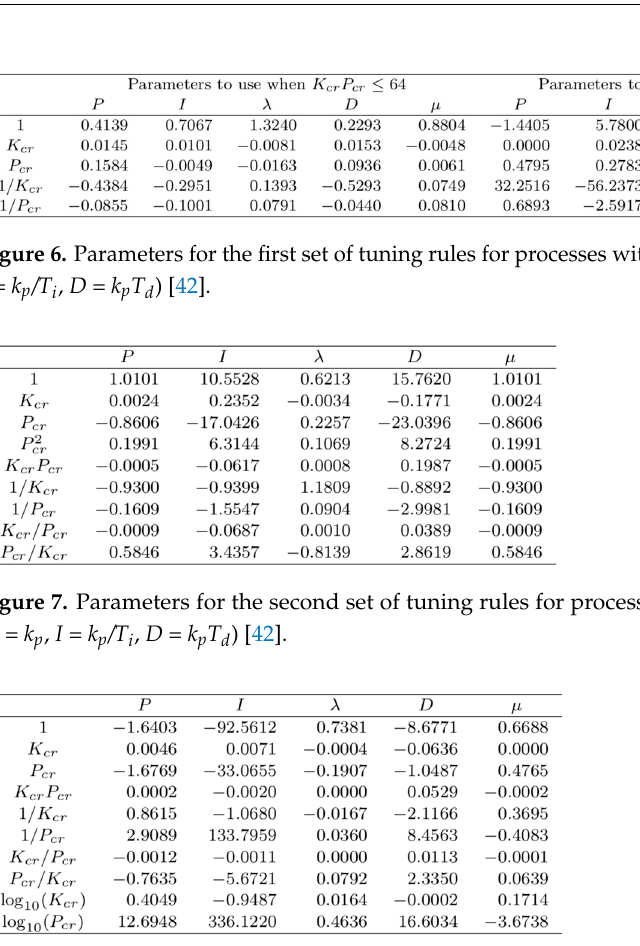
( P = k p , I = k p /T i , D = k p T d ) [42].